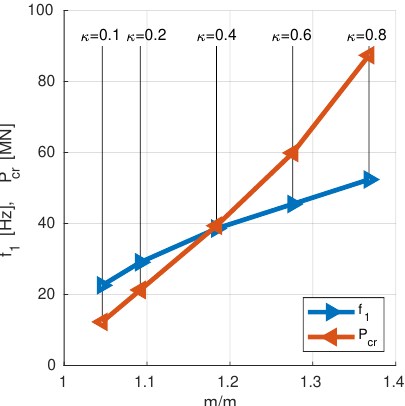
Figure 13. The optimal values of f 1 and P cr in relation of the relative mass of the